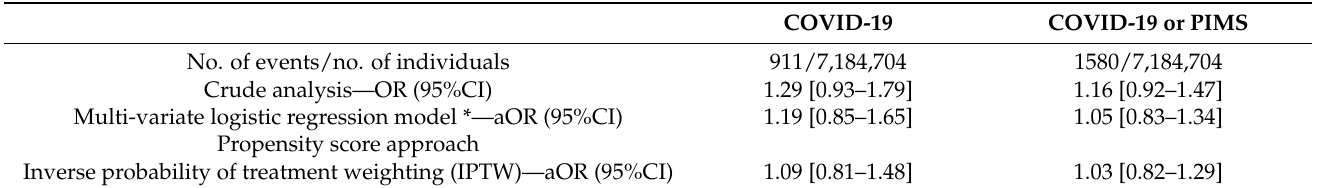
Table 2. Associations between exposure to MMR vaccine and COVID-19 hospitalization outcomes. COVID-19 COVID-19 or